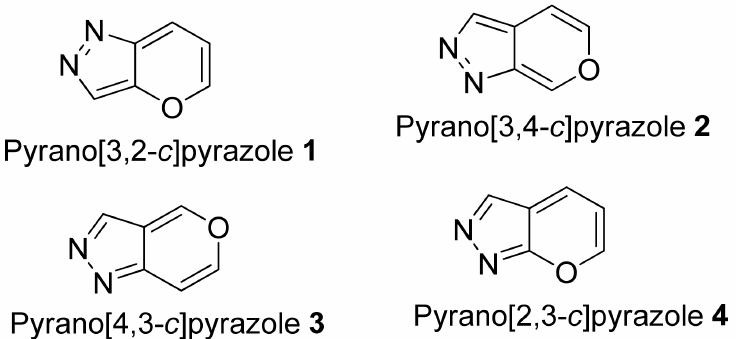
Figure 2. Four pyranopyrazole